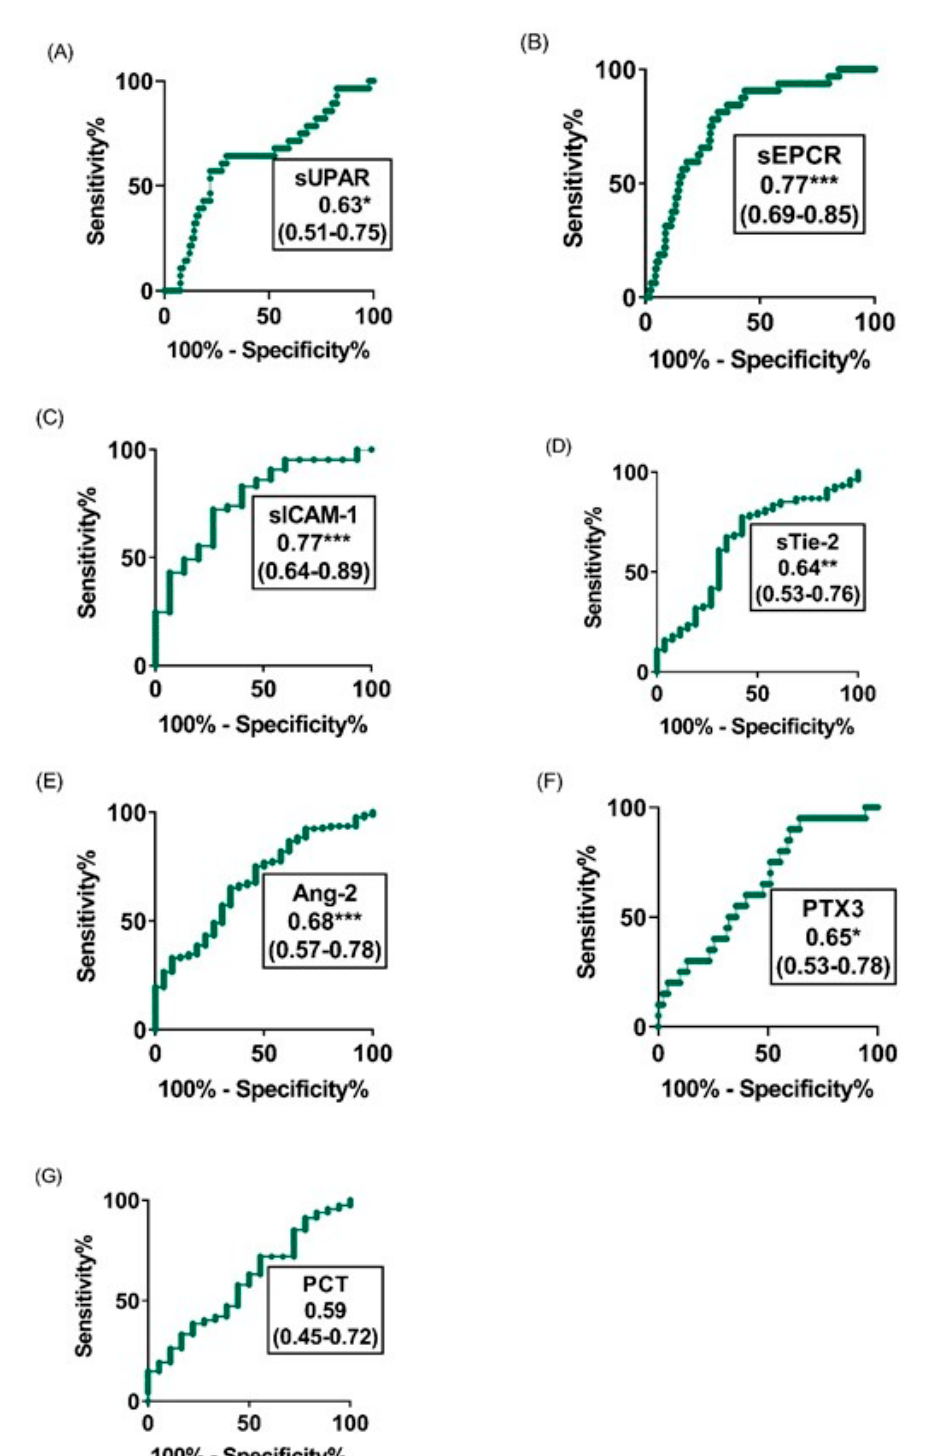
Figure 6. ROC curve analyses of the individual prediction performance of sEPCR, sICAM-1, sTie-2, Ang-2, PTX3, suPAR and PCT to differentiate fatal from non-fatal cases on the day of admission to hospital. ( A – G ), Assessment by ROC curve analyses of the individual prediction performance of on the day of admission to hospital, patients who will survive from those who will subsequently die. The area under the curve as well as the confidence intervals are indicated in the legend. The * indicates 0.01 < p value < 0.05, ** 0.001< p value < 0.01, *** indicates p value ≤ 0.001.